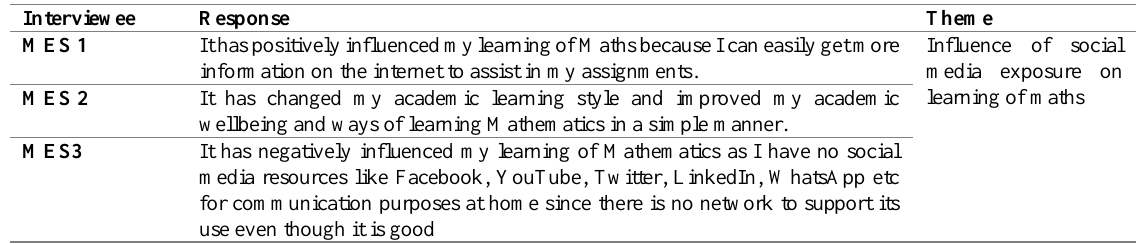
Table 10: Question 10 - How has social media exposure influenced your learning of Mathematics in your class?